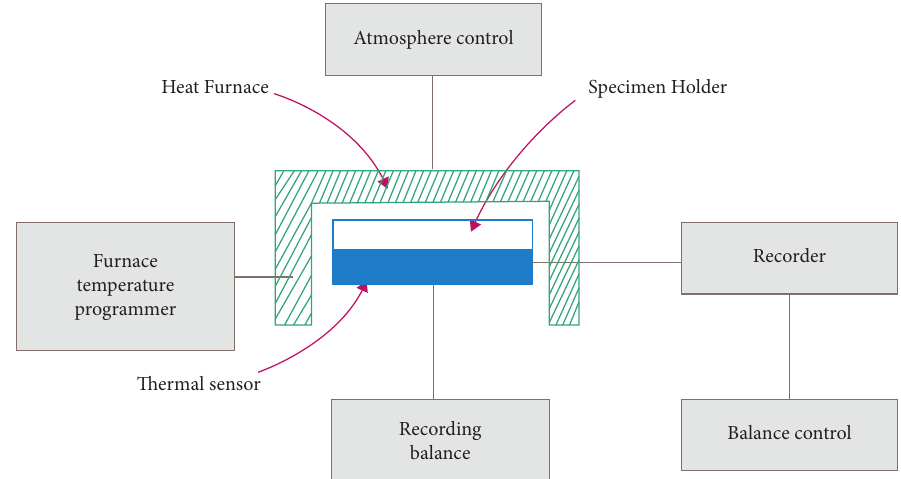
Figure 3: Schematic flow of thermogravimetric analysis.